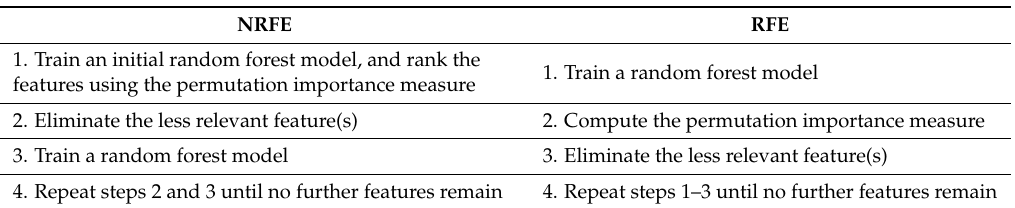
Table 5. The processes of non-recursive feature elimination (NRFE) and recursive feature elimination (RFE) algorithms for variable